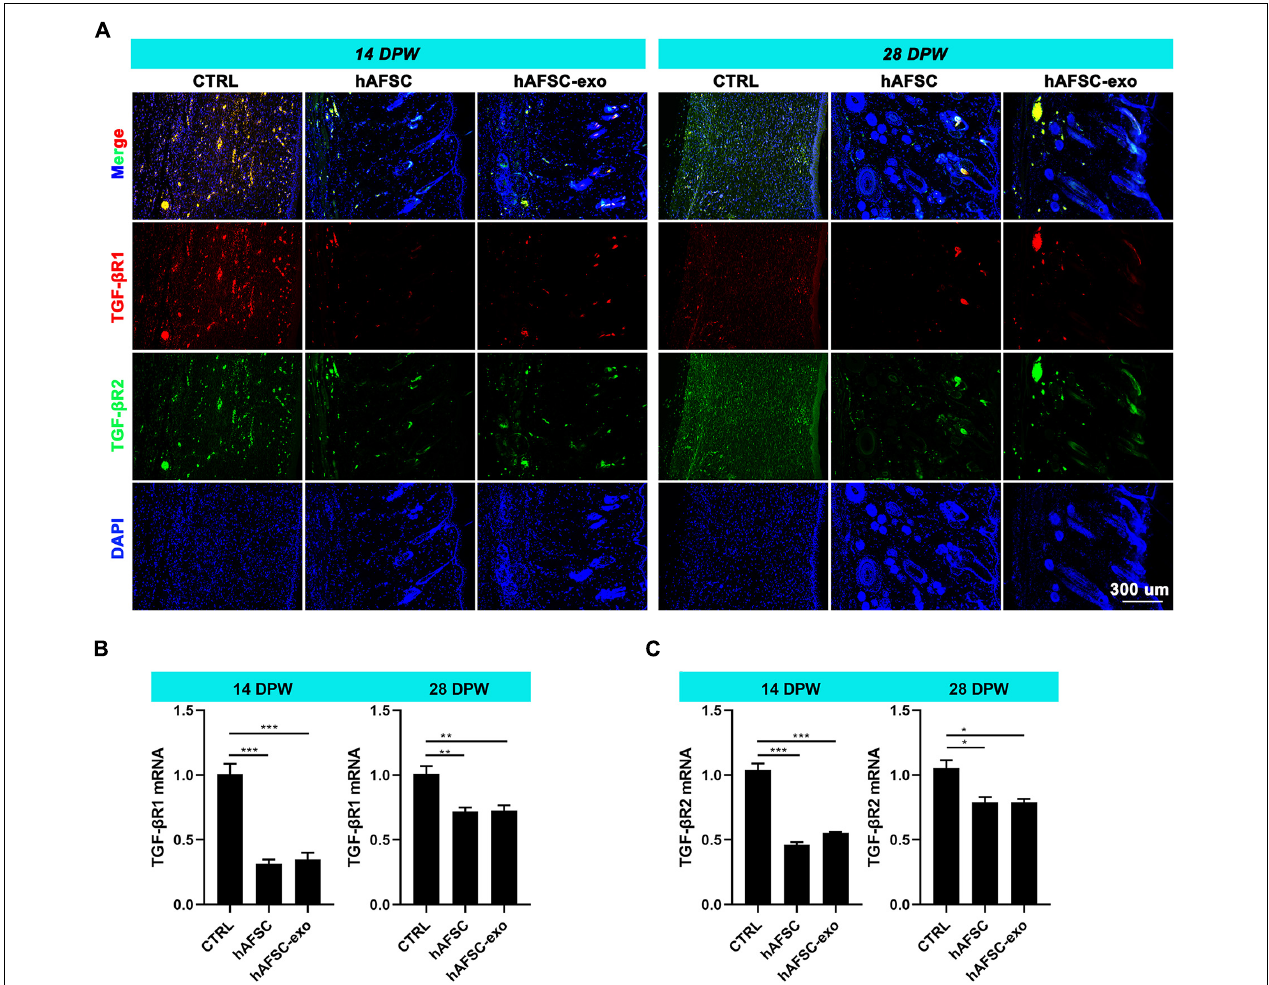
FIGURE 6 | hAFSC-exo inhibited TGF- β R1 and TGF- β R2 expression on wound healing in rats. (A) IF staining of TGF- β R1 and TGF- β R2 in the healed tissues (scale bar = 300 µ m). (B,C) mRNA levels of TGF- β R1 and TGF- β R2 in the healed tissues. Mean ± SD; * P < 0.05; ** P < 0.01; *** P < 0.001; n = 5. TGF- β R1, transforming growth factor- β receptor type I, TGF- β R2, transforming growth factor- β receptor type